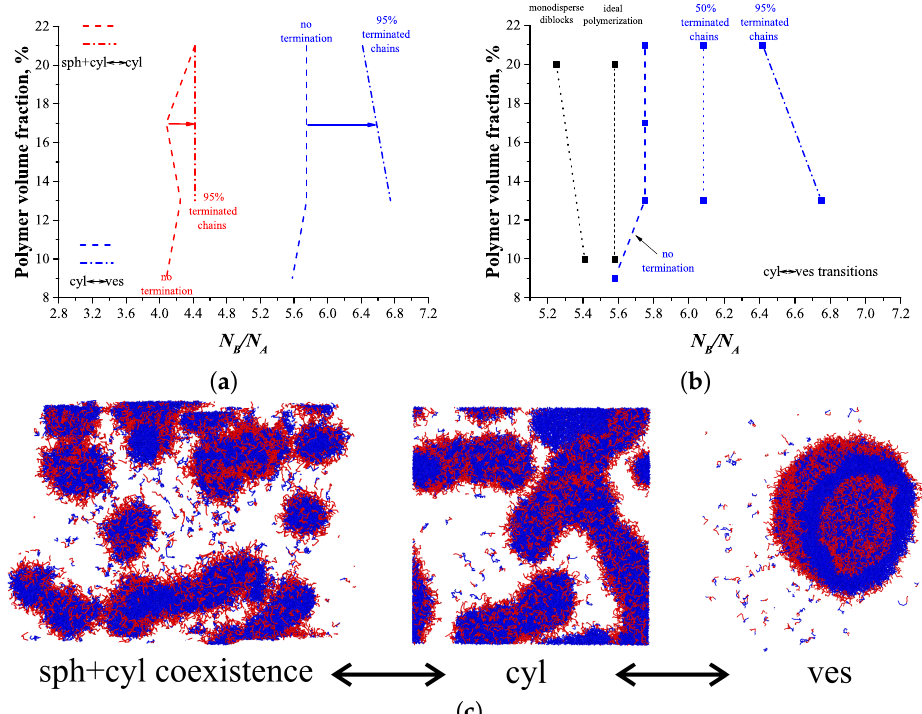
Figure 3. ( a ) Phase diagram for the systems without recombination ( p t = 0, transition lines are dashed) and for the systems with the fraction of terminated chains via recombination equal to ≈ 95% ( p t = 0.05, transition lines are dash-dotted). Sph+cyl and cyl regions are to the left and to the right side of the red lines, respectively. Cyl and ves regions are to the left and to the right side of the blue lines, respectively. ( b ) Transition lines between cylinders and vesicles for the systems with different fractions of terminated chains. Squares show the simulation data. Transition points for the reference systems (monodisperse diblock copolymers and ideal polymerization PISA at 10% and 20%) were obtained in ref. [21] and are shown in black. The cyl<->ves transition points were tested in three independent runs for the systems with 95% of terminated chains. ( c ) Snapshots of the observed